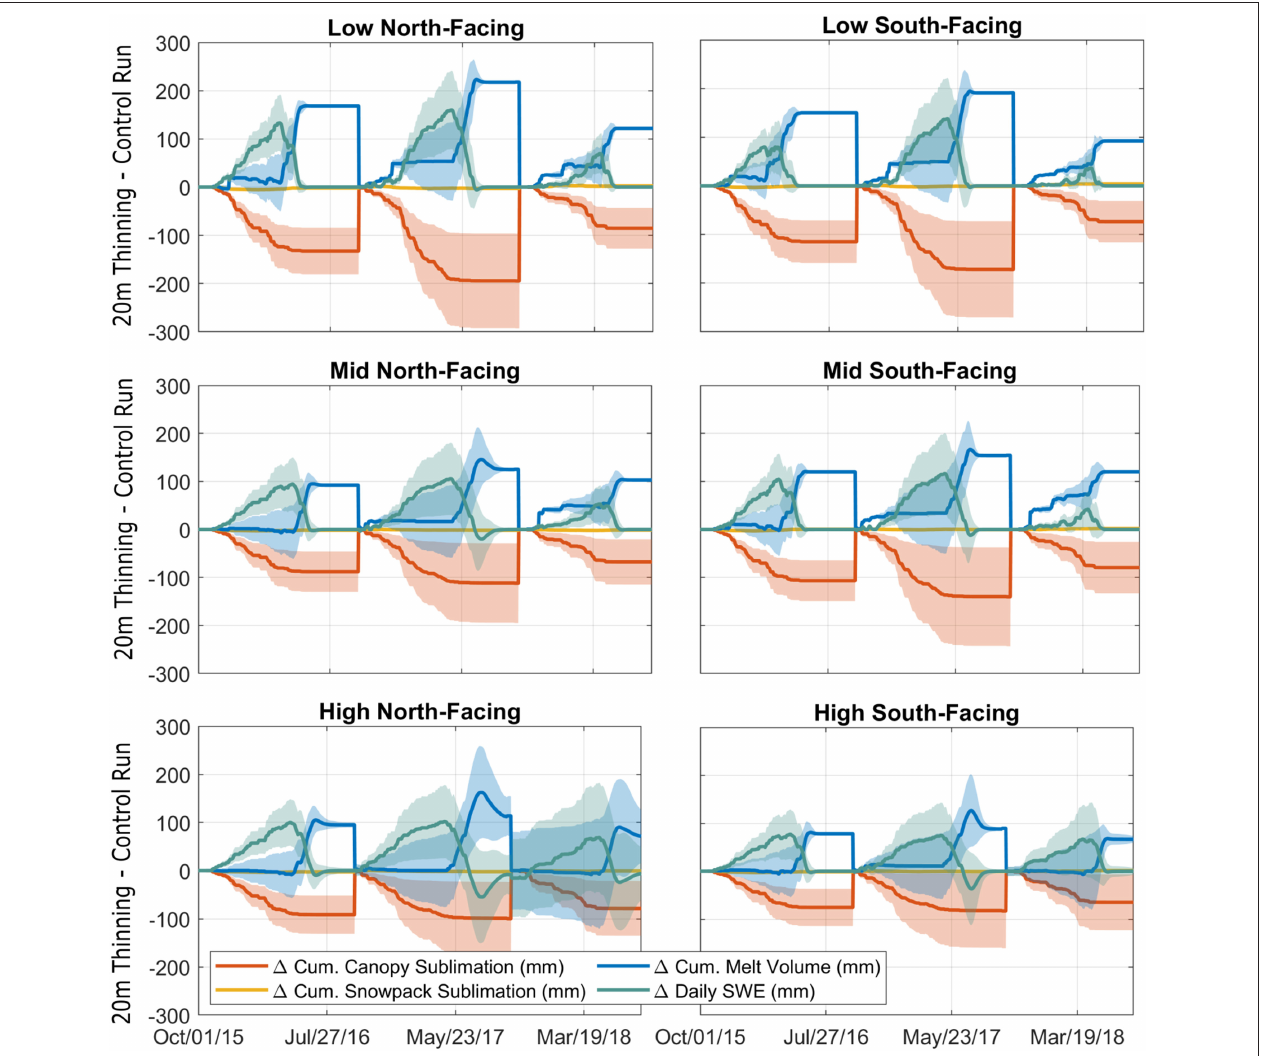
FIGURE 9 | Time series of changes to cumulative mass fluxes and daily SWE for six representative Snow Zones between the 20-m thinning scenario and the control